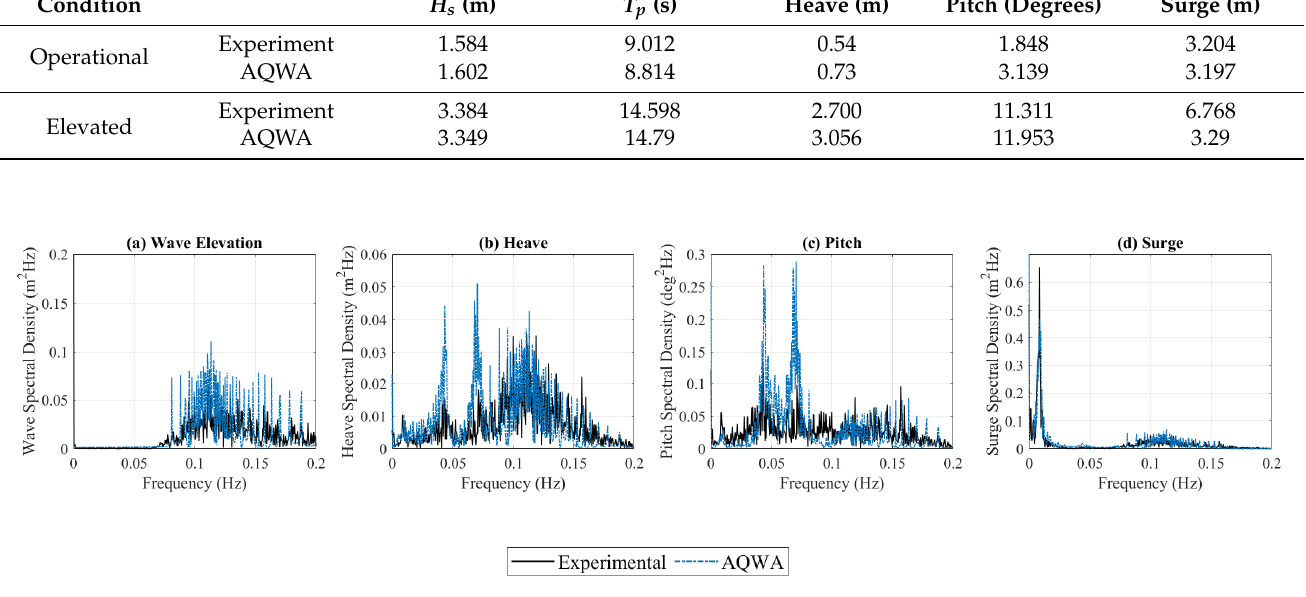
Figure 9. Experimental and numerical results for an operational, irregular sea state ( H s = 1.584 m, T p = 9.012 s): ( a ) wave spectral density, ( b ) heave spectral density, ( c ) pitch spectral density, and ( d ) surge spectral density.